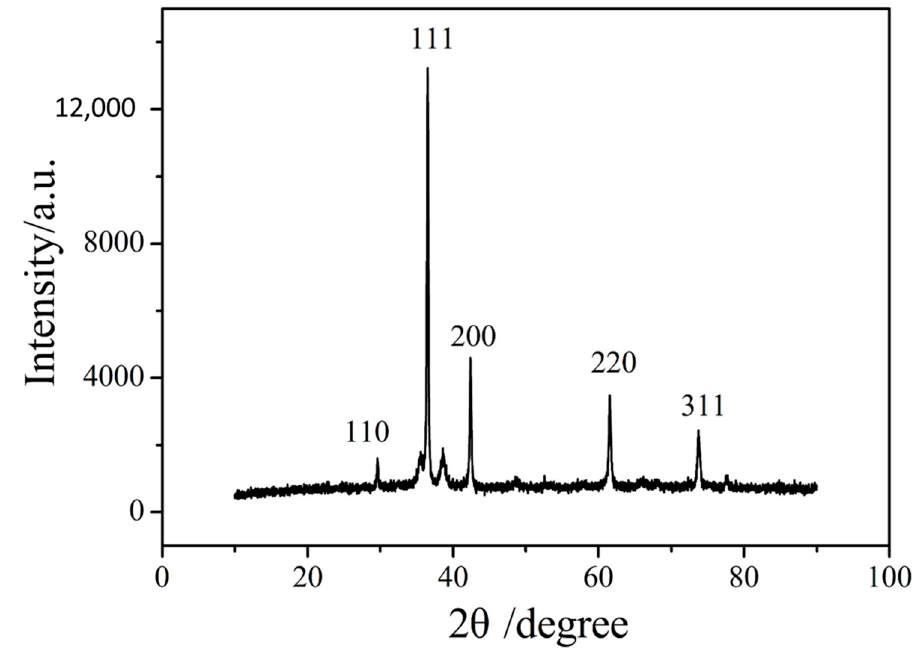
Biomolecules 2019 , 9 , 176 Figure 1. The XRD pattern of Cu 2 O nanoparticles. Figure 1. The XRD pattern of Cu 2 O nanoparticles.